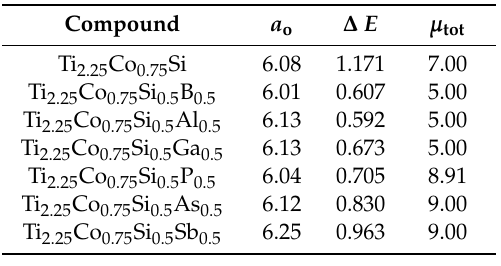
Table 1. The optimized equilibrium lattice parameter, a o (Å); the energy di ff erence (cid:52) E (eV) between anti-ferromagnetic (AFM) and ferromagnetic (FM) states; and the total magnetic moment µ tot ( µ B ) of the studied compounds.